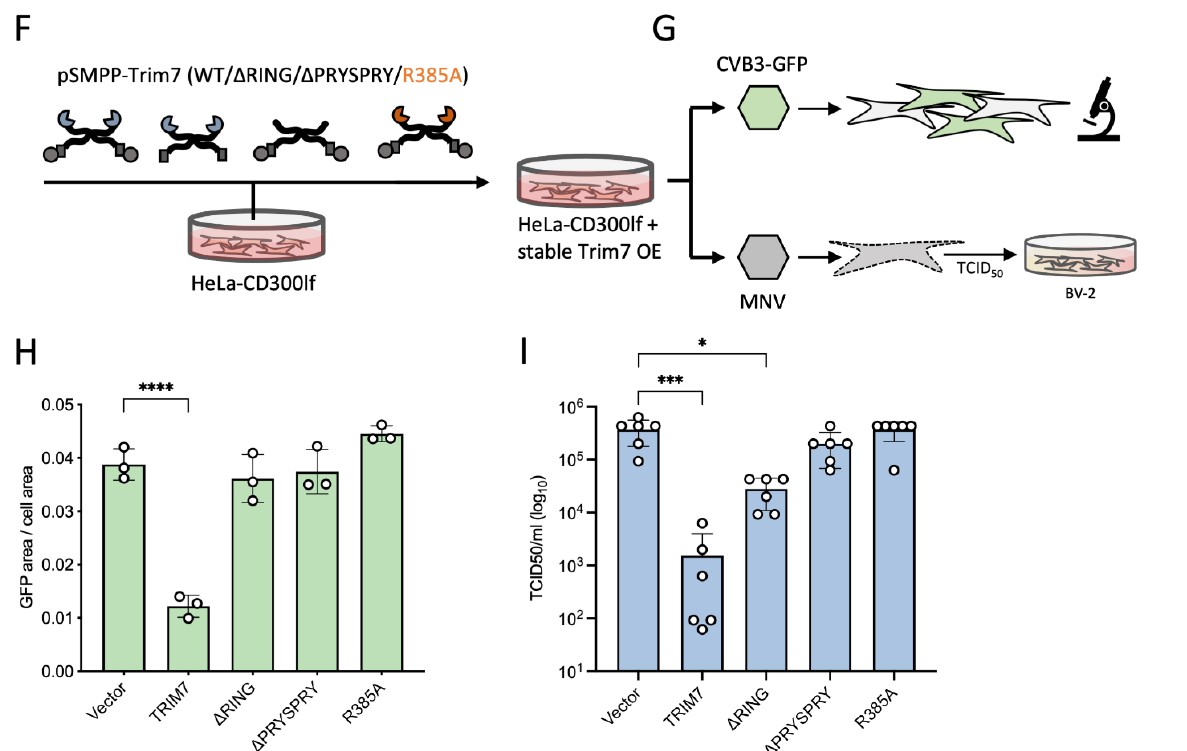
Figure 4. TRIM7 restriction of MNV1 and CVB3 infection is driven by helix- Φ Q binding. ( A – C ) Co-transfection of TRIM constructs and reporter plasmids. Overexpression of TRIM7 induces strong signaling by AP-1 and NF- κ B that is dependent on the RING domain. ( D ) Overexpression of TRIM7 induces signaling, as measured by qPCR; values are normalized to actin. ( E ) Point mutation that prevents binding to targets does not impact signaling. For all signaling experiments ( A – E ), representative examples of at least two independent experiments are shown, with values normalized to cells transfected with empty vector. ANOVA was used for statistical analysis and significant differences indicated ( p < 0.0005 (***), p < 0.0001 (****)). ( F , G ) Schematic overview of the experiments shown in H and I. Lentivirus generation and stable transfection of HeLa-CD300lf cells ( F ), with the expression confirmed by Western blotting (Figure S6). Cells were infected with recombinant CVB3 virus-producing EGFP in host cells or MNV1 ( G ). ( H ) Quantification of CVB3 infection by measuring the fraction of EGFP-expressing cells. Data shown are from three independent experiments. ( I ) Quantification of MNV1 replication by TCID50 following infection of TRIM7-expressing cells. Virions from lysed cells were titrated onto susceptible BV-2 cells. Data shown are a representative result of three independent experiments. Error bars show the standard deviation. Non-parametric ANOVA was used for statistical analysis and significant differences indicated ( p < 0.05 (*), p < 0.0005 (***), p < 0.0001 (****)).